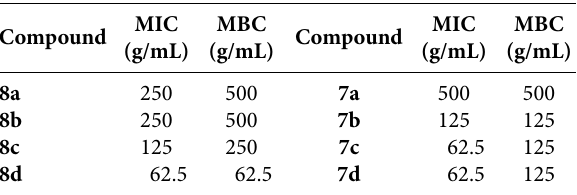
Table 1 . In vitro antibacterial activity of synthetic compounds against E. coli . MIC MBC MIC MBC Compound Compound (g/mL) (g/mL) (g/mL) (g/mL)